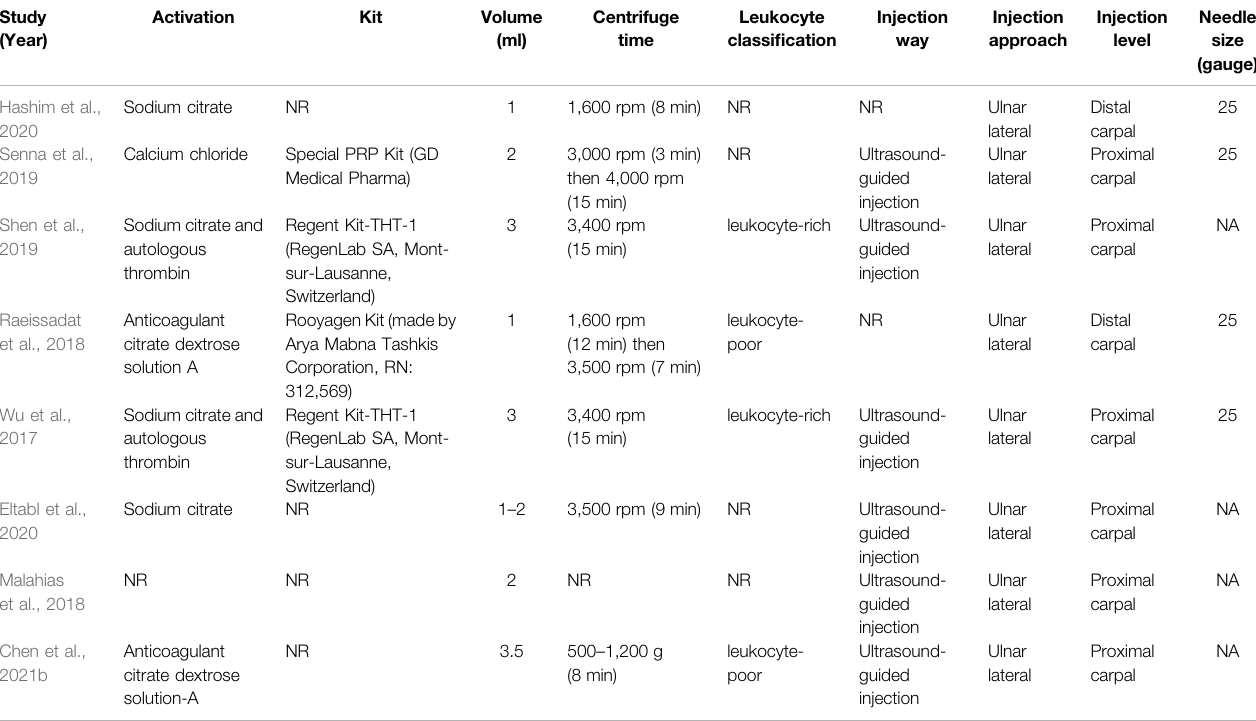
TABLE 2 | The characteristics of Platelet-rich plasma